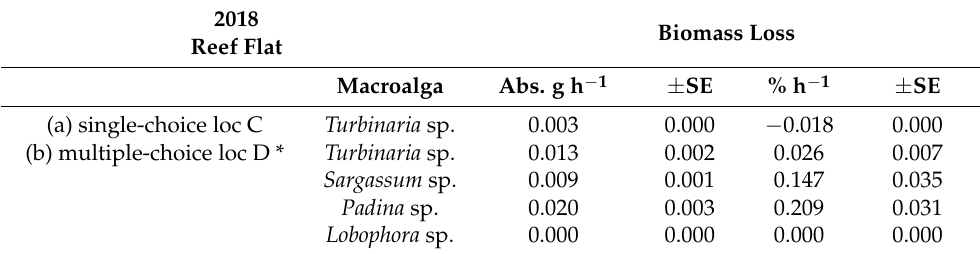
Table 5. Biomass loss of macroalgae in single-choice assays at loc C (a) and multiple-choice assays at loc D (b) on the reef flat in 2018. Given are absolute biomass loss in g h − 1 ± SE as well as biomass loss in % h − 1 ± SE per algae genus. Locations with significant biomass loss are marked with